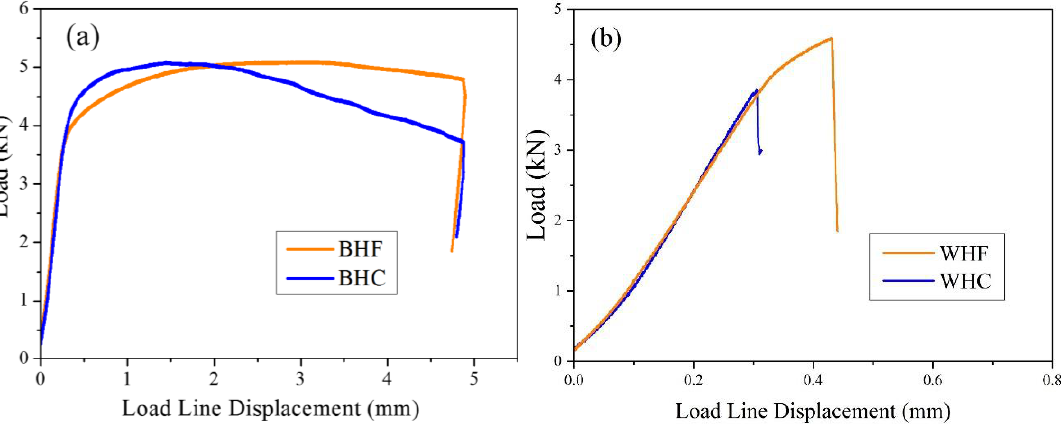
Figure 4. The variation of load with respect to the displacement. ( a ) and ( b ) represent BM and WM specimens under hydrogen-free (HF) and hydrogen-charged (HC) conditions.